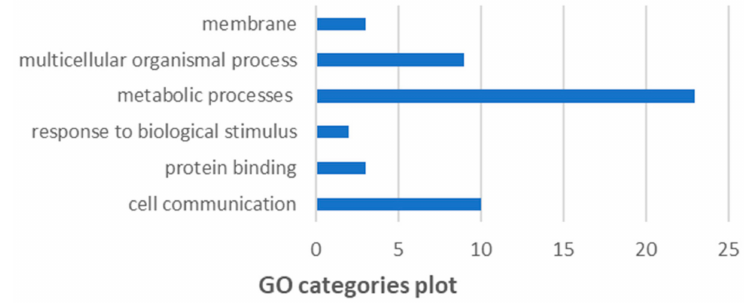
Figure 8. Gene set enrichment analysis of target genes based on GO categories. Table 3. KEGG pathway enrichment analysis of target genes under study. Total = total number of genes participating in pathway, Expected = minimum number of genes to be considered as